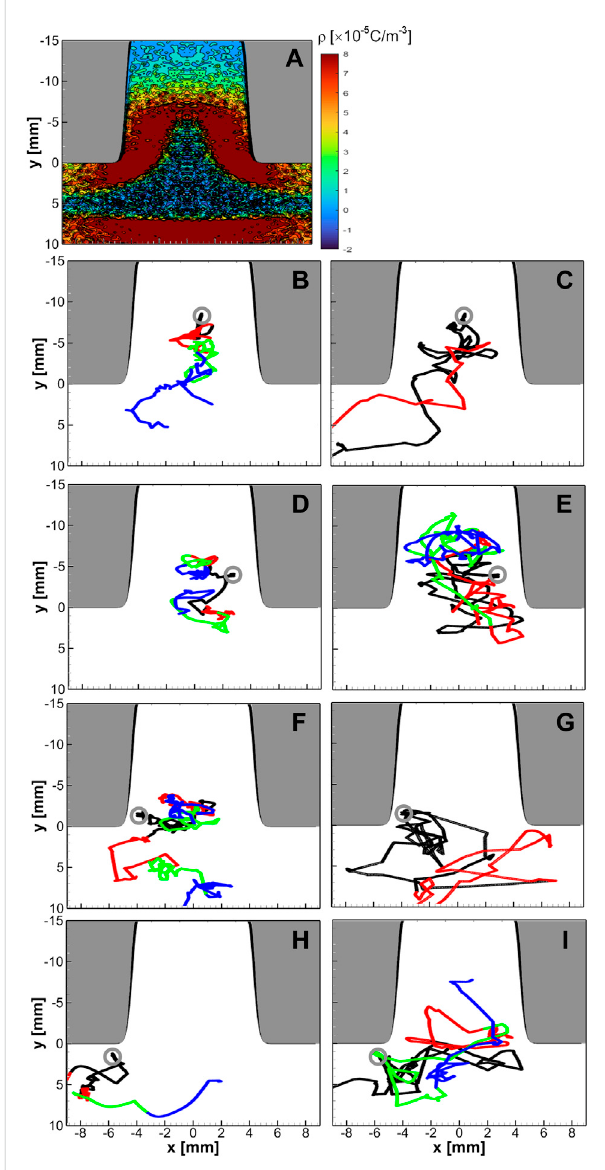
FIGURE 10 Shown are (A) the time-averaged spatial pro fi les of the space chargedensity for thesameconditionsas thecase ofFigures 8B, (B – I) the particle trajectories of two test particles which started from four different locations (grey circles) for the sheath-expanding (left) and the sheath-shrinking (right) phases, following the voltage phases shown in Figure Figures 8A, B show the spatial pro fi les of the time-averaged electron density and the electron temperature. The phase-resolved electron temperature, electron power absorption, and the EERL are shown for the deep and wide hole ( h = 15 mm and d = 8 mm) for 0.4 Torr (Figure 8A) and 0.6 Torr (Figure 8B). Deep holes and high gas pressure enhance electron temperature in the bulk region (Figure 8D). The EERL decreases inversely proportional to gas pressure, and thus 0.6 Torr case shows two-density peaks fi nally. The electron heating shown in Figure 8E shows the electrons are heated inside the hole, following a well-known HC effect. However,